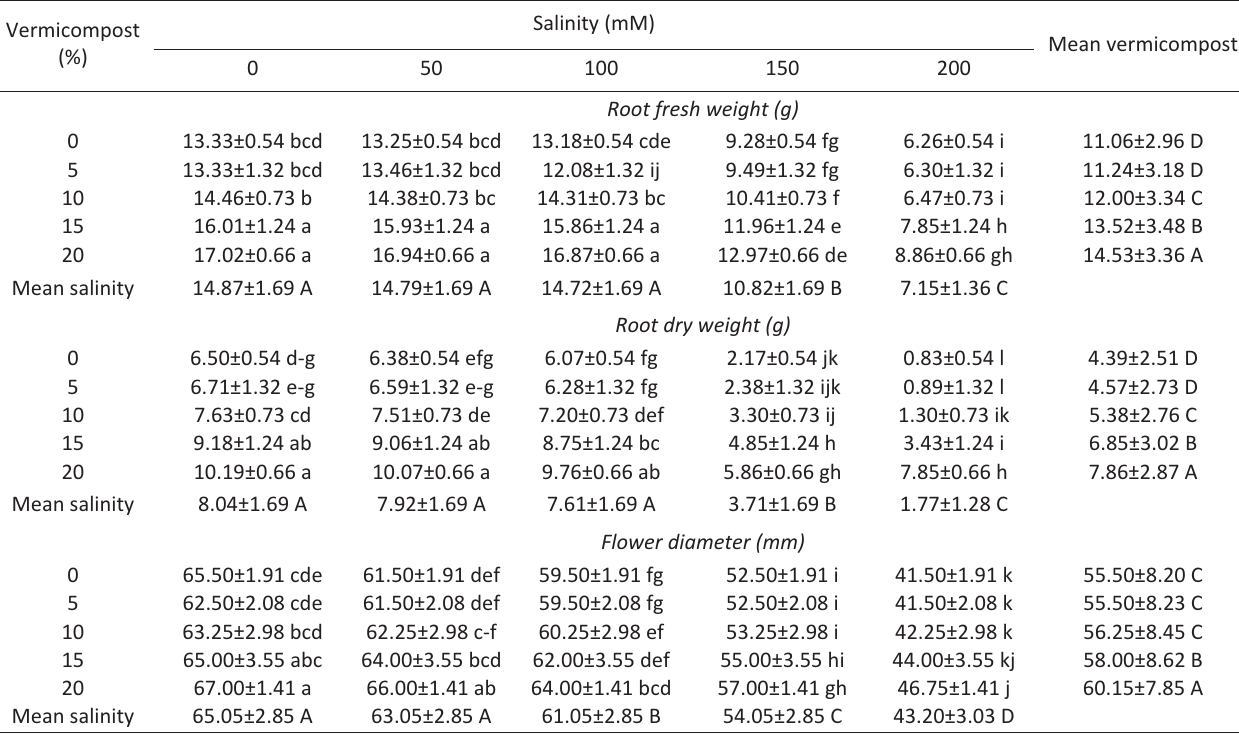
* In each variable, data followed by the same letters (small letters for interactions and capital letters for means) are not significantly dif- ferent using LSD at 5%level. Data represent the mean value ± S.D. the mean of four